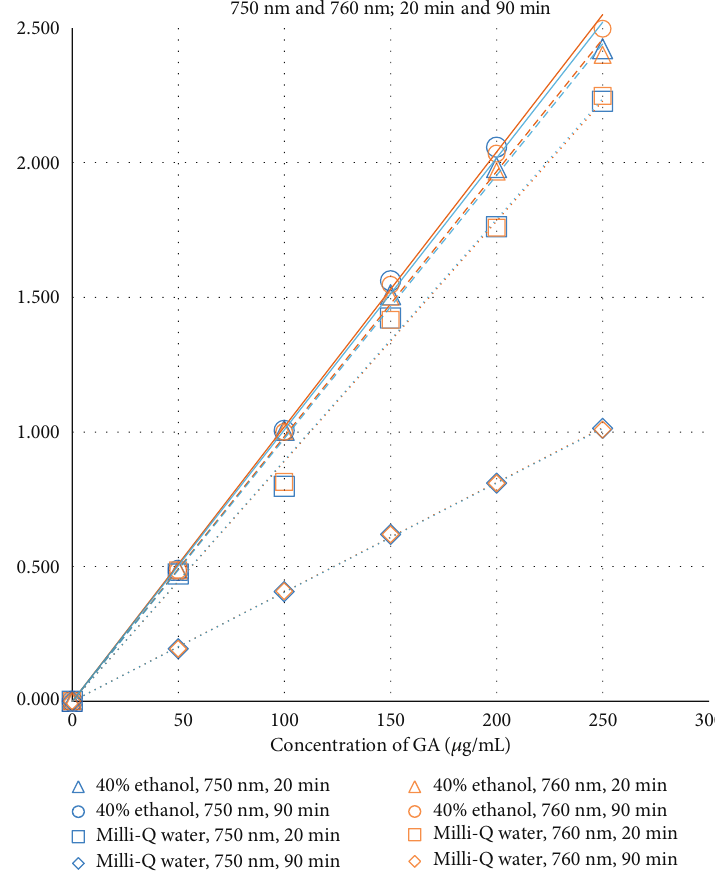
Figure 4: Calibration curves of GA standards in 40% ethanol and Milli-Q water, at 750nm and 760nm, after 20 min and 90 min of incubation. Table 5: Slope of calibration curves (from Figure 4) in di ff erent solvents at di ff erent time points and at di ff erent wavelengths. Assay solvent and time 750 nm 760nm FC-TPC assay in 40% ethanol;